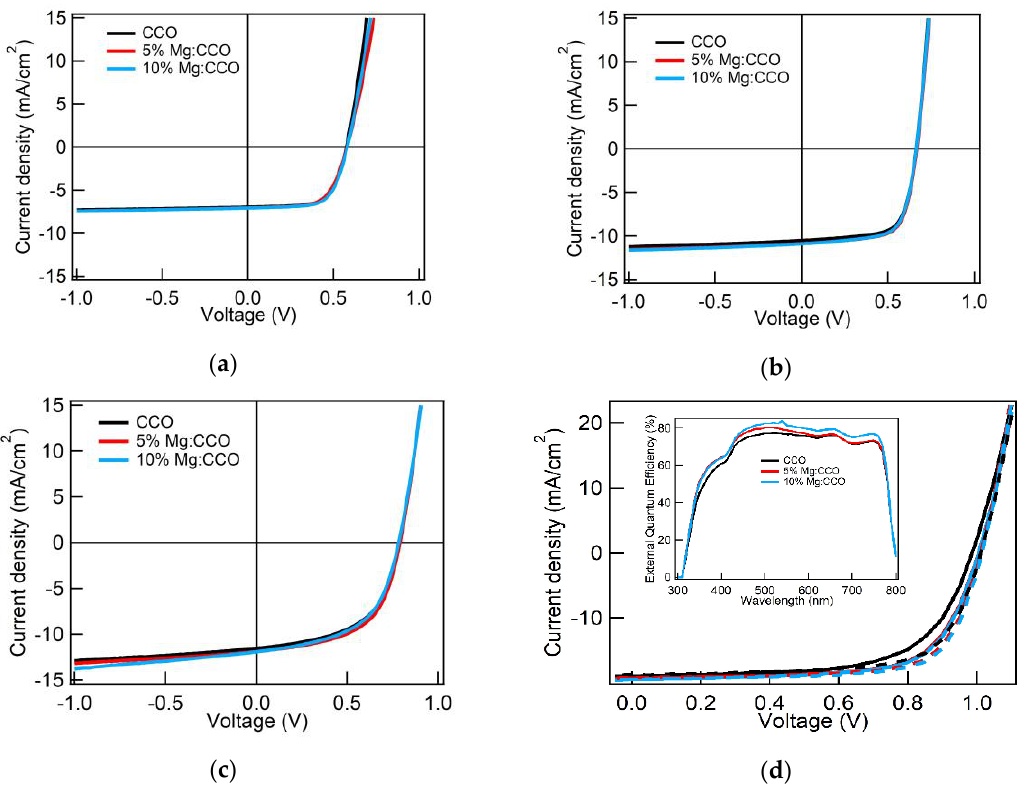
Figure 10. Average J-V curves (number of devices for each system is given in the footer of Table 4) of ( a ) P3HT:PC 61 BM OSCs, ( b ) PFBT2Se2Th:PC 71 BM OSCs, ( c ) PTB7-Th:ITIC OSCs, and ( d ) MAPbI 3 PSCs measured in AM 1.5G 100 mW cm − 2 illumination with CCO (black curve), 5% Mg:CCO (red curve), and 10% Mg:CCO (blue curve) hole transport layers (HTLs). In (d), solid J-V curves are measured under forward scan, dashed J-V curves are measured under reverse scan, and the inset is the external quantum e ffi ciency (EQE) measurements of representative MAPbI 3 cells with CCO (black curve), 5% Mg:CCO (red curve), and 10% Mg:CCO (blue curve)